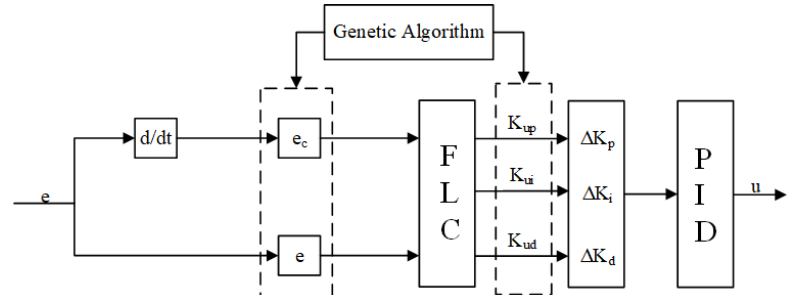
ZO Table 3. Fuzzy rule of ∆𝐾 𝑑 . EC E